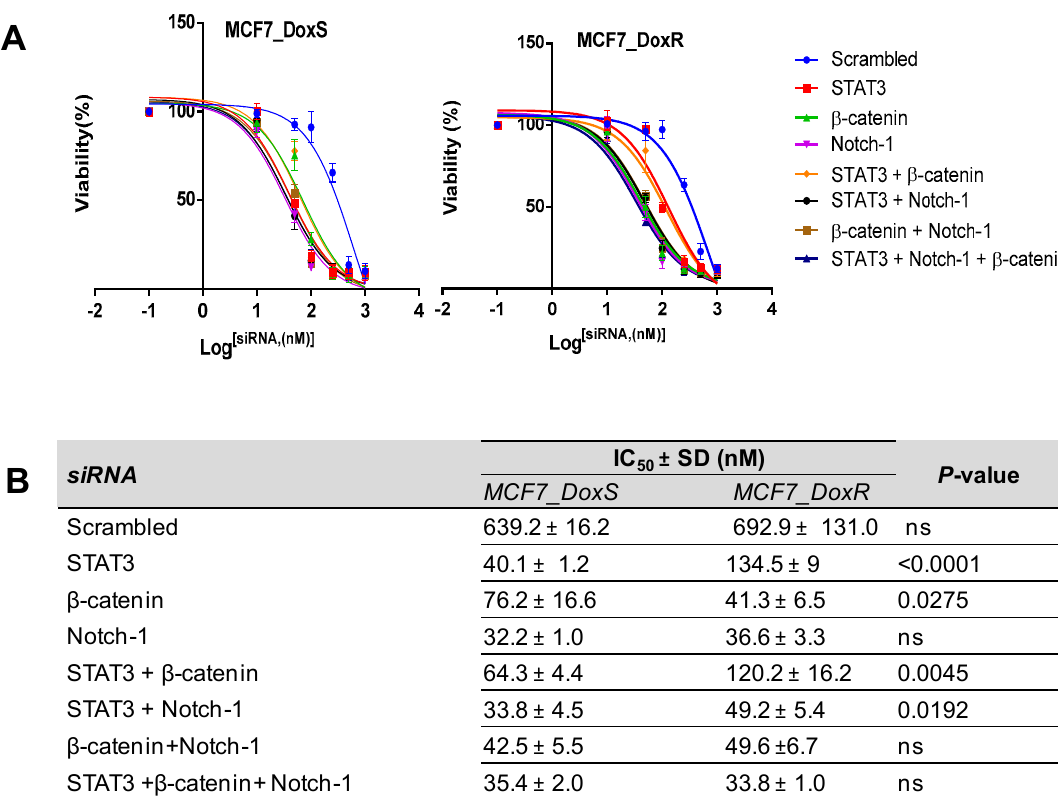
Figure 6. Dose–response curves and the IC 50 values after siRNA treatment. The cell lines were treated with different concentrations of single and combinations of siRNAfor 72 h to assess the anti-proliferative effect on MCF7_DoxS and MCF7_DoxR cells. ( A ) The dose–response curves and ( B ) the IC 50 values of single and combinations of siRNA in MCF7_DoxSand MCF7_DoxR cells. Scrambled siRNA was used as a negative control for comparison. All IC 50 values represent the average of three independent experiments ± SD with four replicates per siRNA concentration for each experiment.